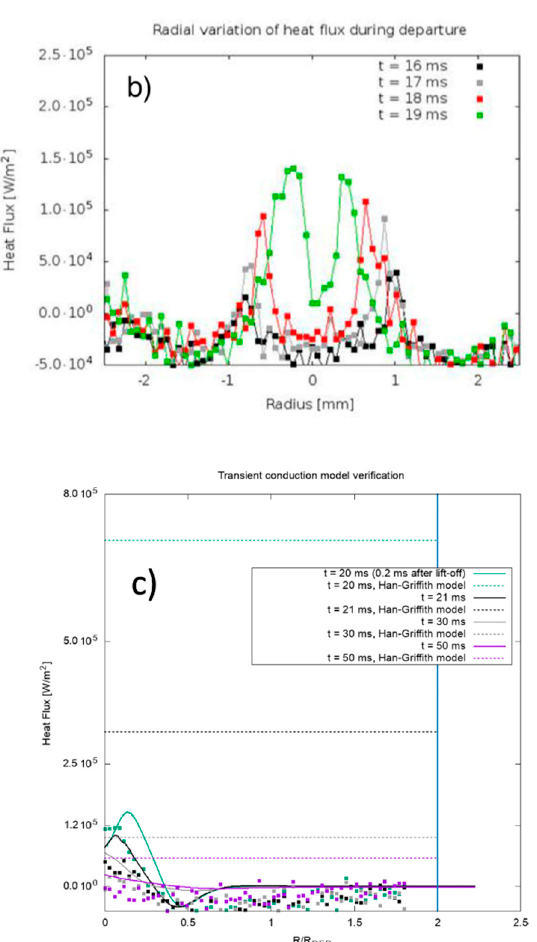
Figure 11. Panels ( a , b ) indicate, respectively, the bubble shape and heat flux distribution at the solid surface reconstructed from measurement. Panel ( c ) shows comparison of heat flux distributions at the solid surface beneath a bubble from interface-capturing simulation (solid lines) and from the experiment (squares). The dashed lines represent predictions of the heat flux from the solid surface to the liquid obtained with the physical model used for RPI simulation of boiling at the component scale. From Giustini et al. [69,74].